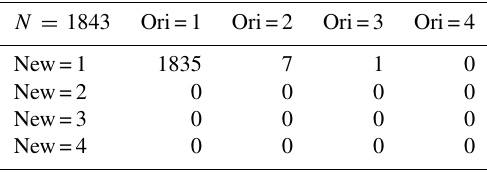
Table 5. Confusion matrix for P168, O092981, B107, camera